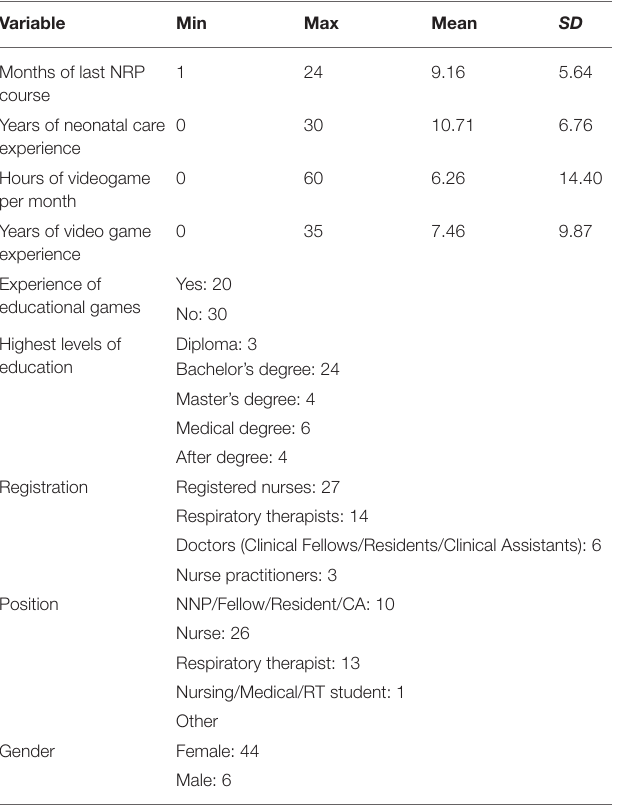
TABLE 1 | Descriptive statistics of participants’ gender, time since last NRP course, highest level of education, registration, position, years of experience in clinical neonatal care, and experience of video games and educational games. Variable